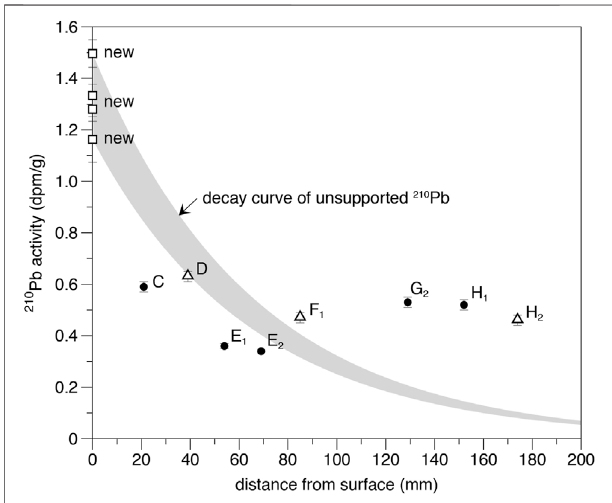
FIGURE 5 | Activity of 210 Pb for the growth zones versus their stratigraphicpositioninthetransect.Asimpleunsupported 210 Pbdecaycurve cannot explain the observed trend as 210 Pb activity does not consistently decrease with distance. The uncertainty shown is 1 standard deviation.